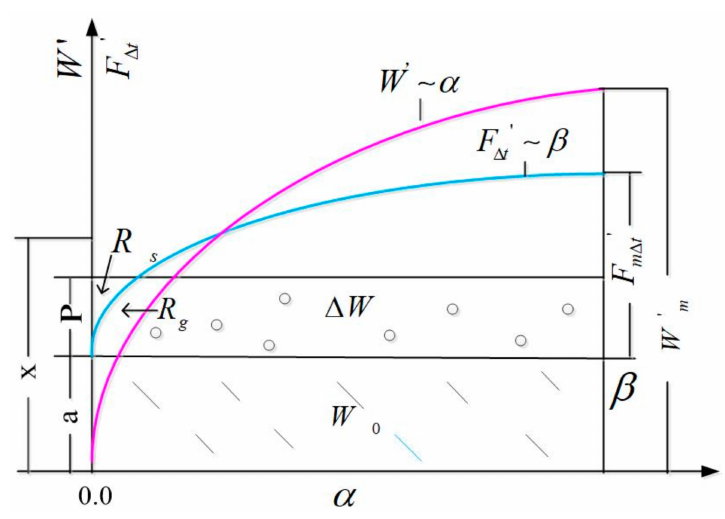
Figure 1. Infiltration and saturation excess runoff